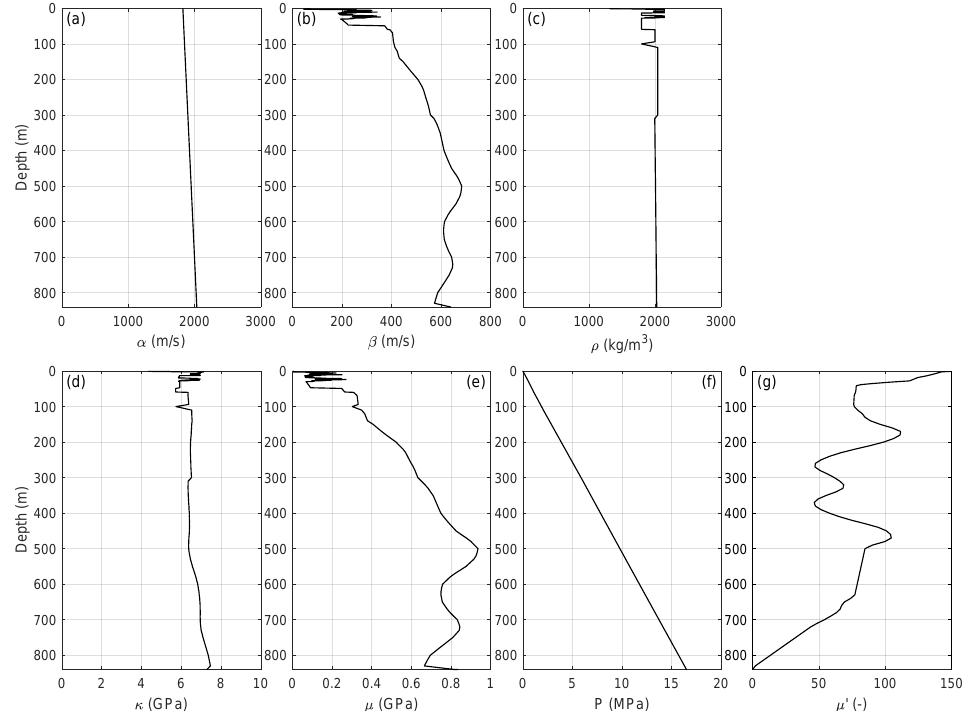
Figure 2. Static models: ( a ) Compressional-wave velocity α , ( b ) shear-wave velocity β , ( c ) mass ρβ 2 , ( e ) shear modulus µ = ρβ 2 , ( f ) confining pressure density ρ , ( d ) bulk modulus κ = ρα 2 − 4 3 (cid:82) z P = ρ ( z ) g dz , with g the gravitational acceleration and z the depth below surface, ( g ) the shear- 0 modulus pressure derivative µ (cid:48) = d µ / dP , based on the smoothed derivative of the shear modulus with respect to confining